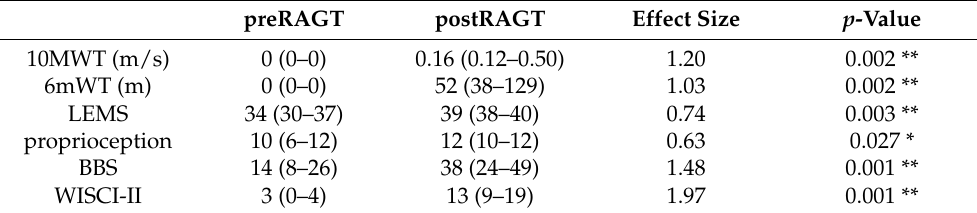
Table 2. Clinical outcome measures at baseline and after intervention.